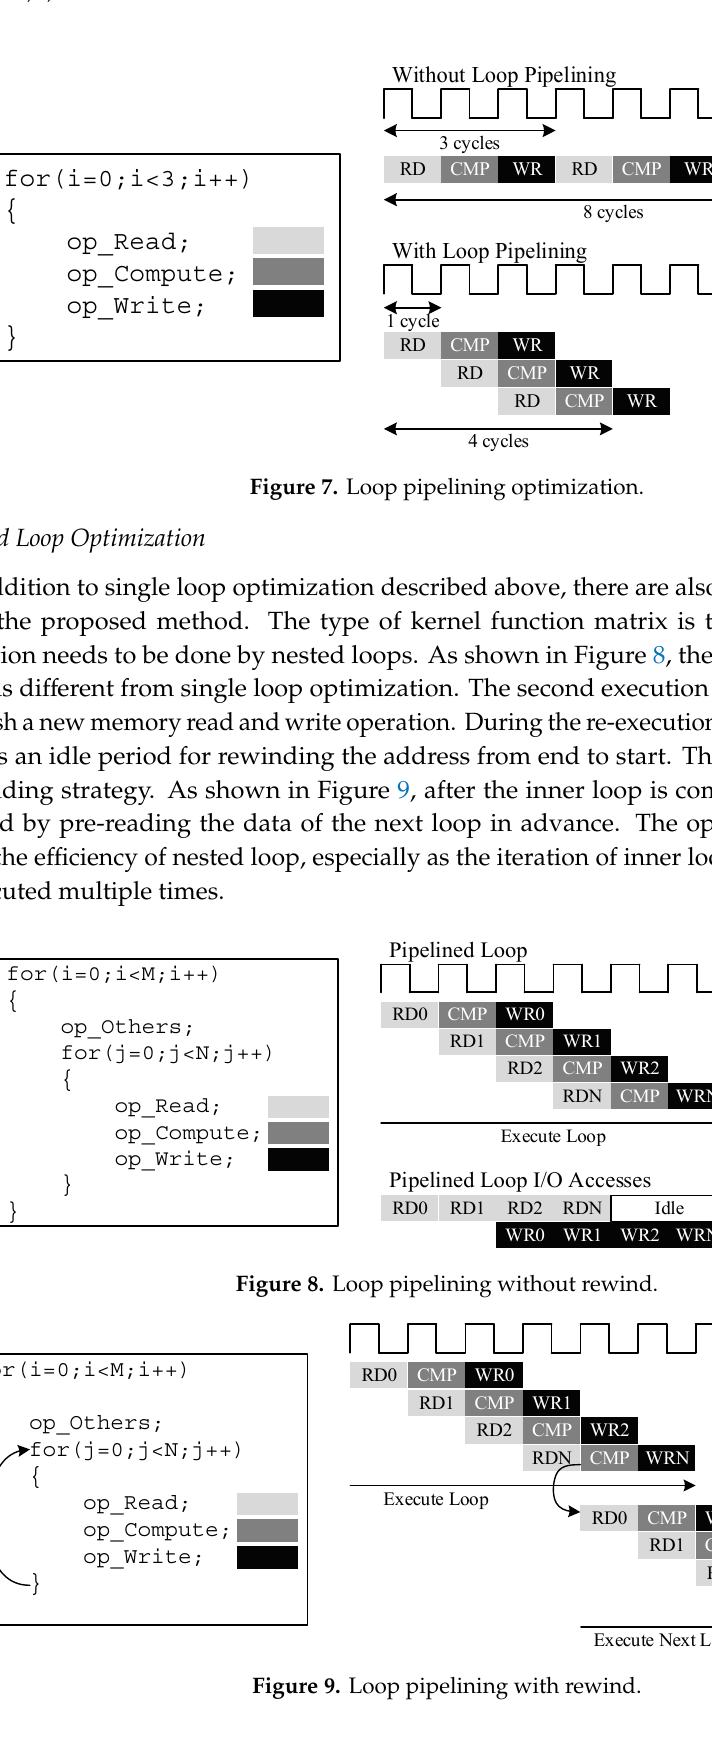
Figure 10. Array partition. 3.4. Other optimizations In addition to the optimization strategies proposed above, others are also used to accelerate training. Multiple matrices are initialized simultaneously using the loop merge method during the data initialization stage. In the [26], adding FIFO to the AXI4-Memory Map improves the ability of DMA to read data. Inline instructions are used in Vivado HLS to reduce the time of function calls. The original training method is accelerated according to the optimization strategy proposed above. Figure 11 shows a flow chart with optimized annotations. Since each stage of training execution includes loop processing of matrix data, the loop pipelining optimization is applied to each stage of the flowchart, and the loop pipelining with rewind optimization is used for the nested loop. Since optimization of array partition is closely related to the type of matrix, it is suitable for the update of gradient matrix G . The loop merge optimization combines multiple unrelated loops and it is suitable for the data initialization of acceleration unit.